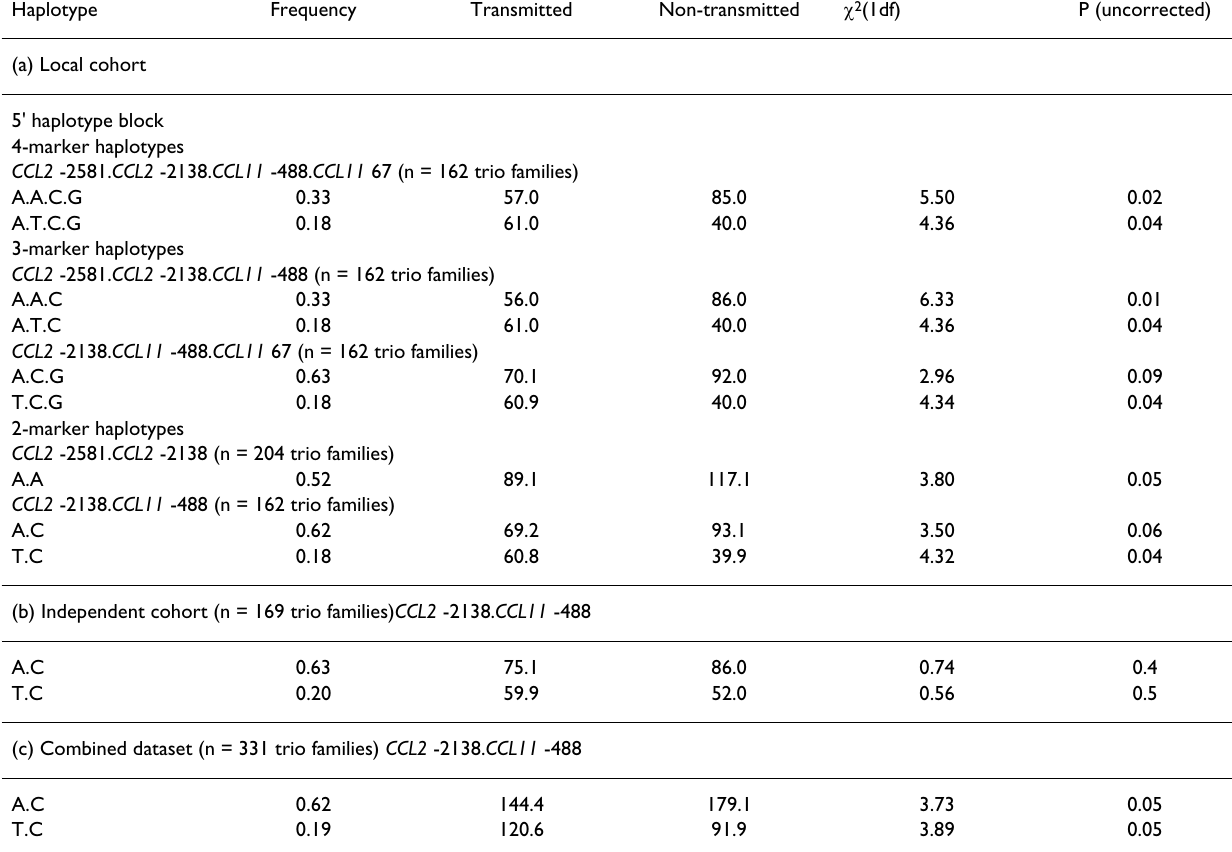
Table 4: Haplotype TDT of CC chemokine gene cluster SNPs.